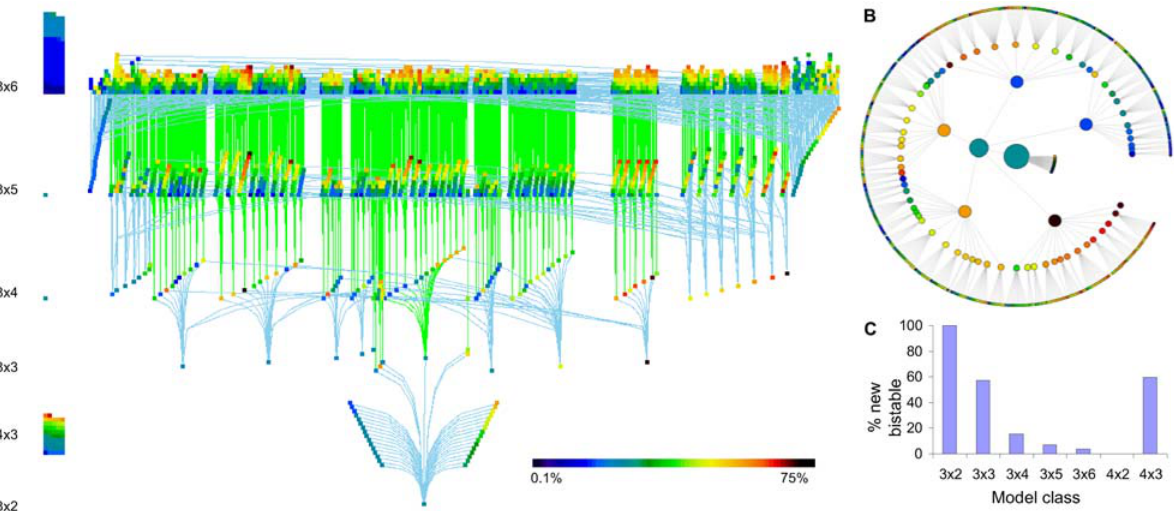
Figure 4. Bistability Runs in Families. (A,B) Representations of relationships between bistable configurations. Node color represents bistability propensity. Color scales for (A) and (B) are the same. (A) ‘‘Banyan tree’’ diagram showing multiple ‘‘root’’ bistable configurations that cannot be generated by addition of a single reaction to a smaller bistable configuration but are connected through larger configurations. Model classes are labeled on the left. Nodes are staggered vertically within bands for visualization. ‘‘Root’’ edges are in sky blue and deeper edges are in green. On the left are orphan models. (B) Minimum spanning tree rooted at 3 6 2M101. Inner nodes with smaller reaction sizes are drawn as larger circles. A few 3 6 3 bistables and the primarily low propensity systems they derive are not shown to minimize crowding. The ‘‘pie’’ denotes restriction of exploration of 4 molecule systems to only 3 reactions in this study. (C) The number of novel bistables drops sharply in larger reaction systems.